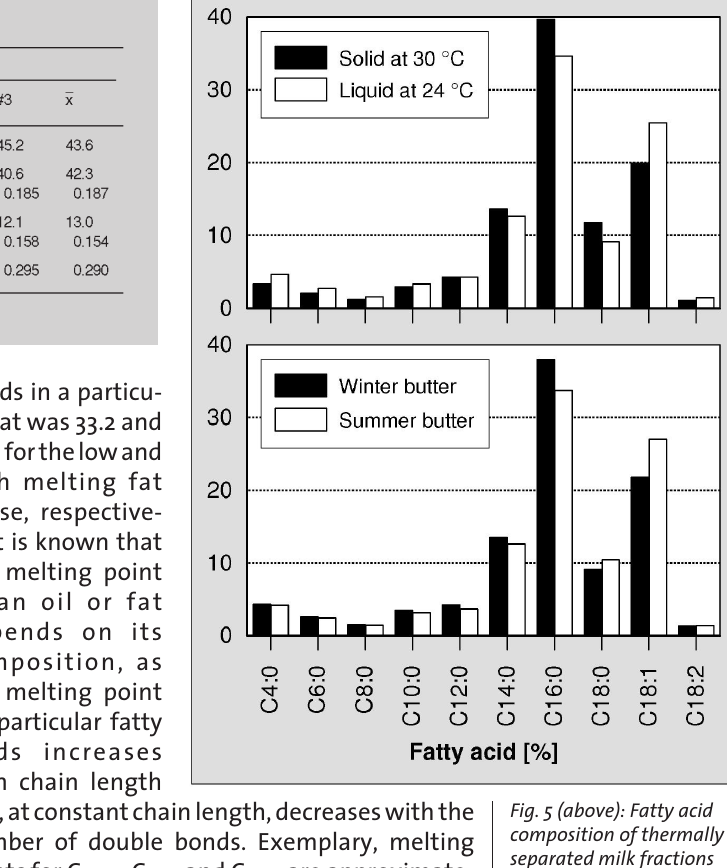
Fig. 5 (above): Fatty acid composition of thermally separated milk fractions (upper Fig.) and different types of butter (lower Fig.) used for model processed cheese manufacture. Table 1: Mechanical para- meter of processed cheeses made from